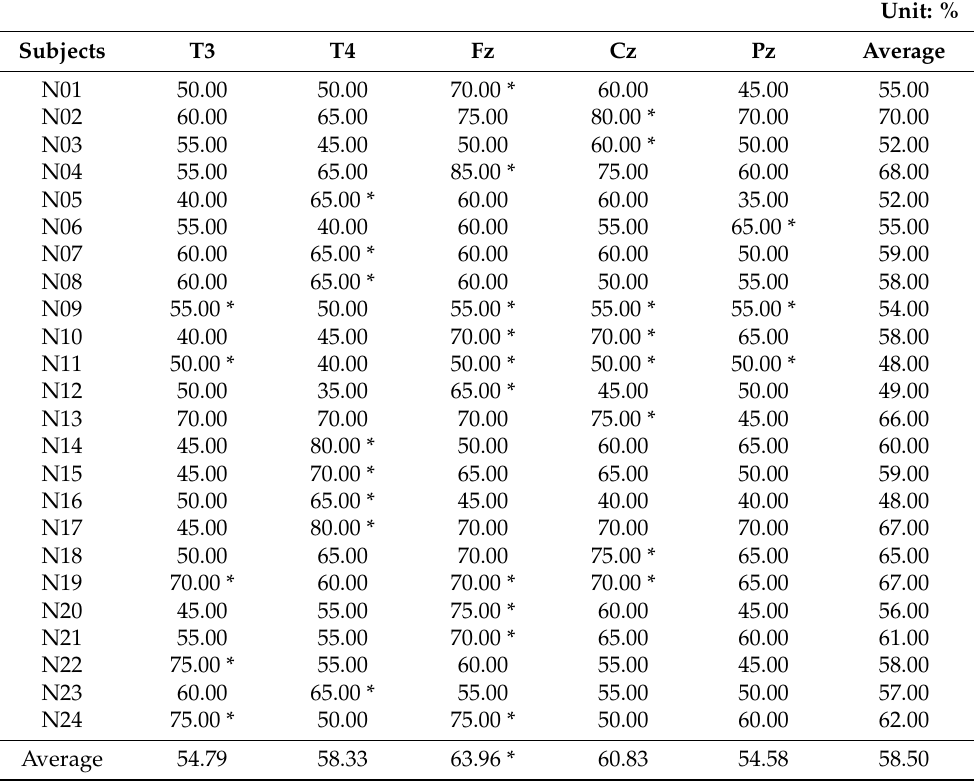
Table 2. The average accuracies by component N200 of the experimental trial using mental Shadowing Tasks.